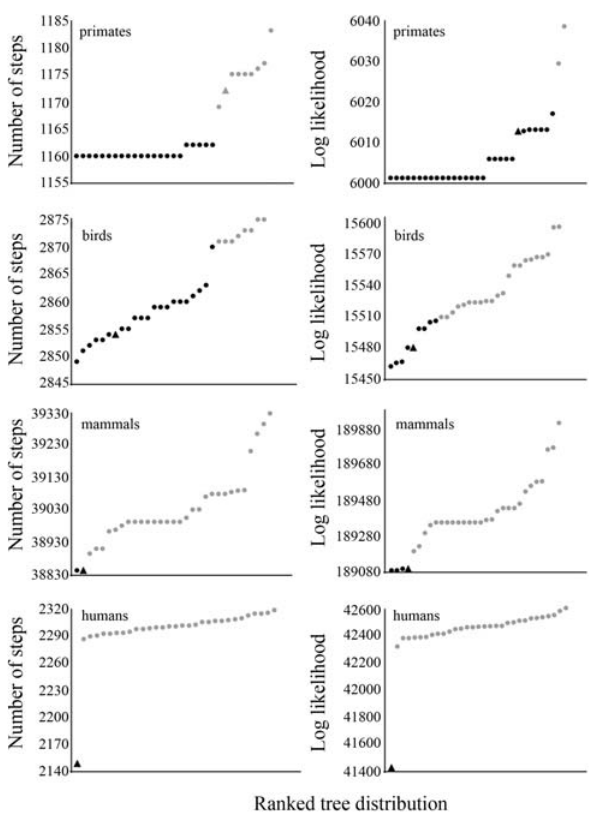
Figure 2 - Comparison of parsimony (leftmost column) and likelihood (rightmost column) scores. Trees are ranked by increasing order of scores. Filled circles are scores for each one of the 30 trees obtained by the ABPR algorithm. Triangle represents score for the tree produced by the NJ algo- rithm.Treeswithscoredifferencesthatarestatisticallyworseaccordingto the Kishino-Hasegawa test are colored in grey and non-significant differ- ences in